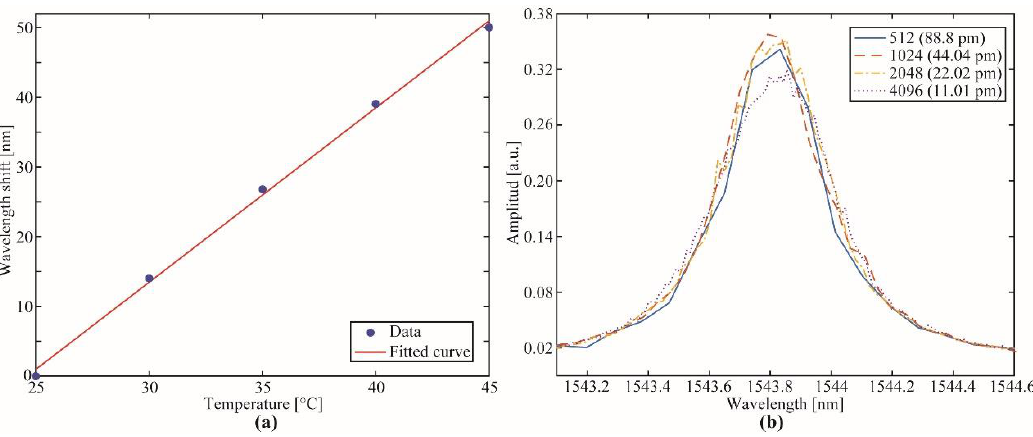
Figure 7. ( a ) FFP-TF wavelength shift as a function of temperature; ( b ) backscattered spectra of FBG as a function of FFP-TF resolution according to the DAC steps.